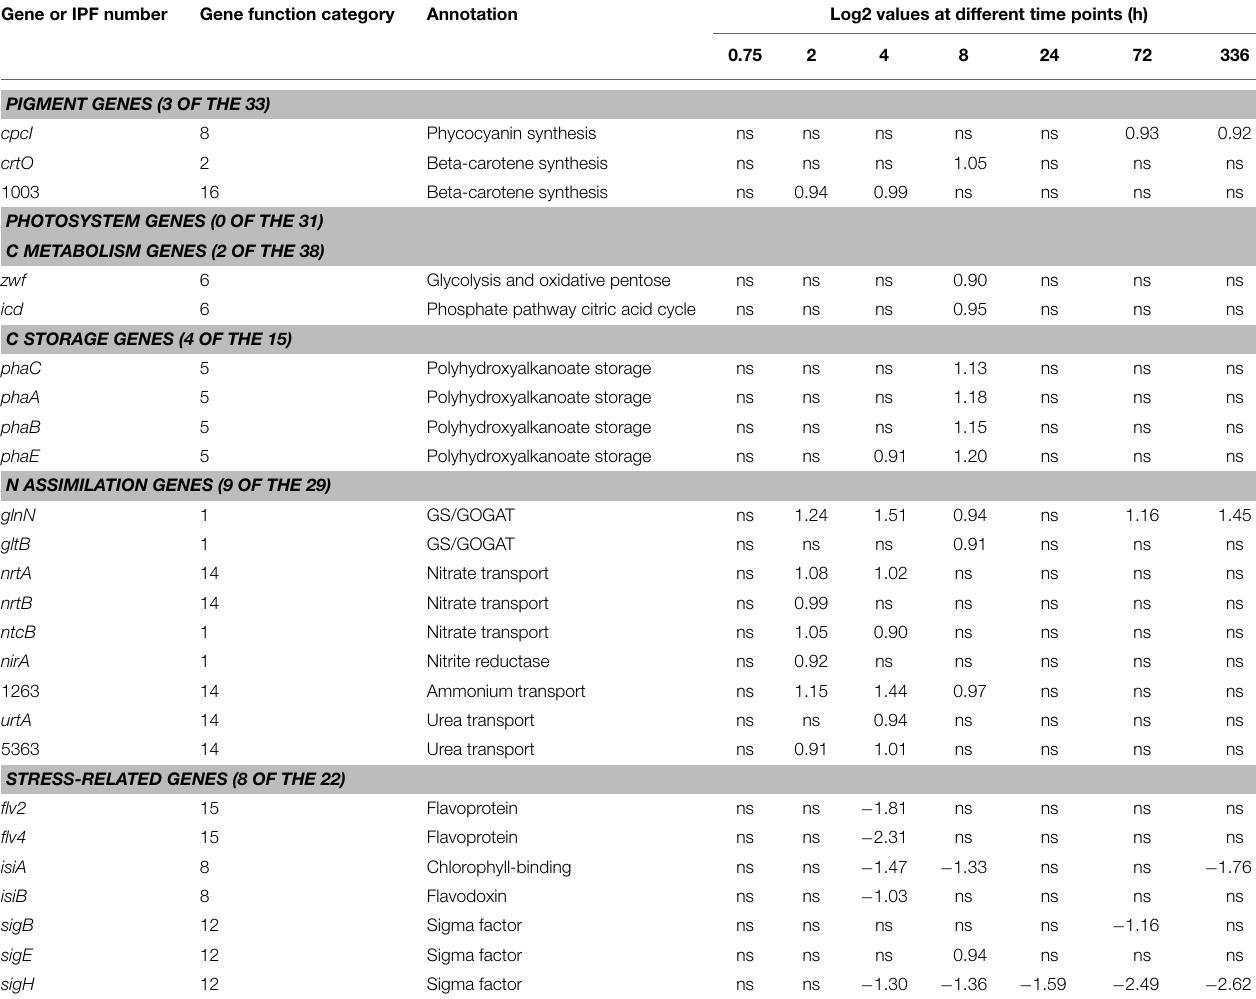
TABLE 1 | Genes responding to rising pCO 2 and involved in pigment synthesis, photosystems, C metabolism, C storage, N assimilation, and stress response. Gene or IPF